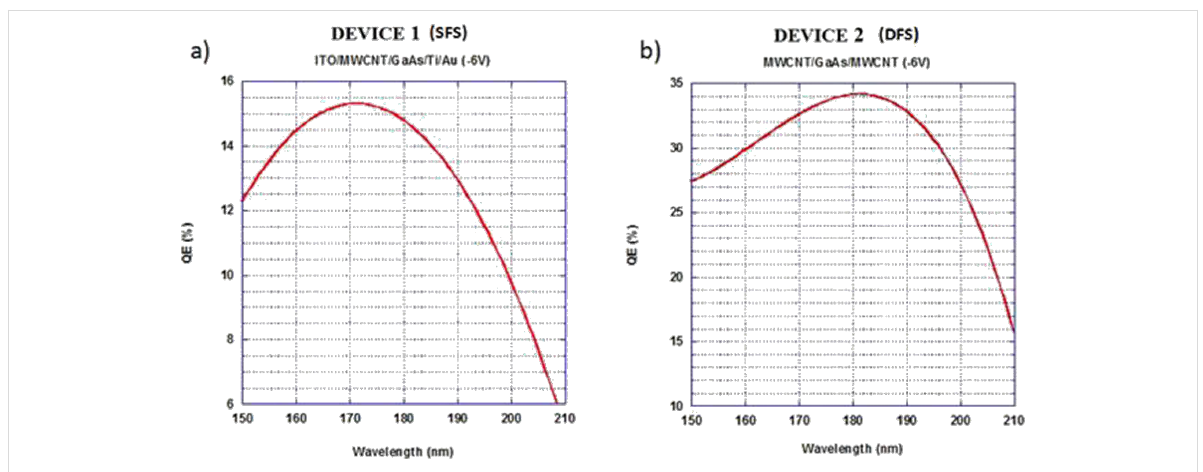
Figure 6: Absolute quantum efficiency trend in the UV range, calculated at a bias voltage of − 6 V for the devices SFS a) and DFS b).